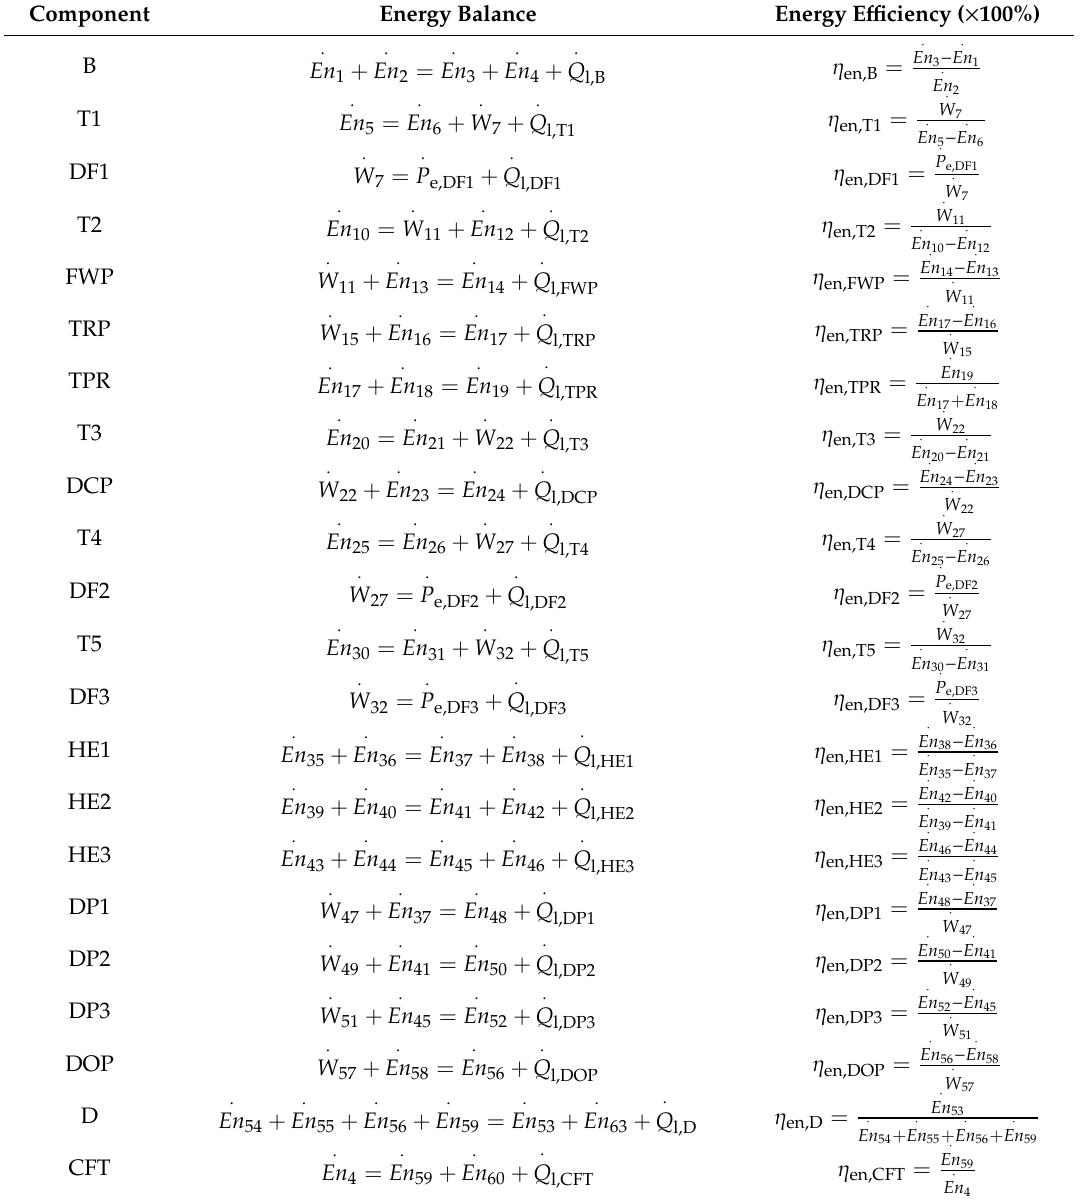
Table A1. Energy balance and energy e ffi ciency of every